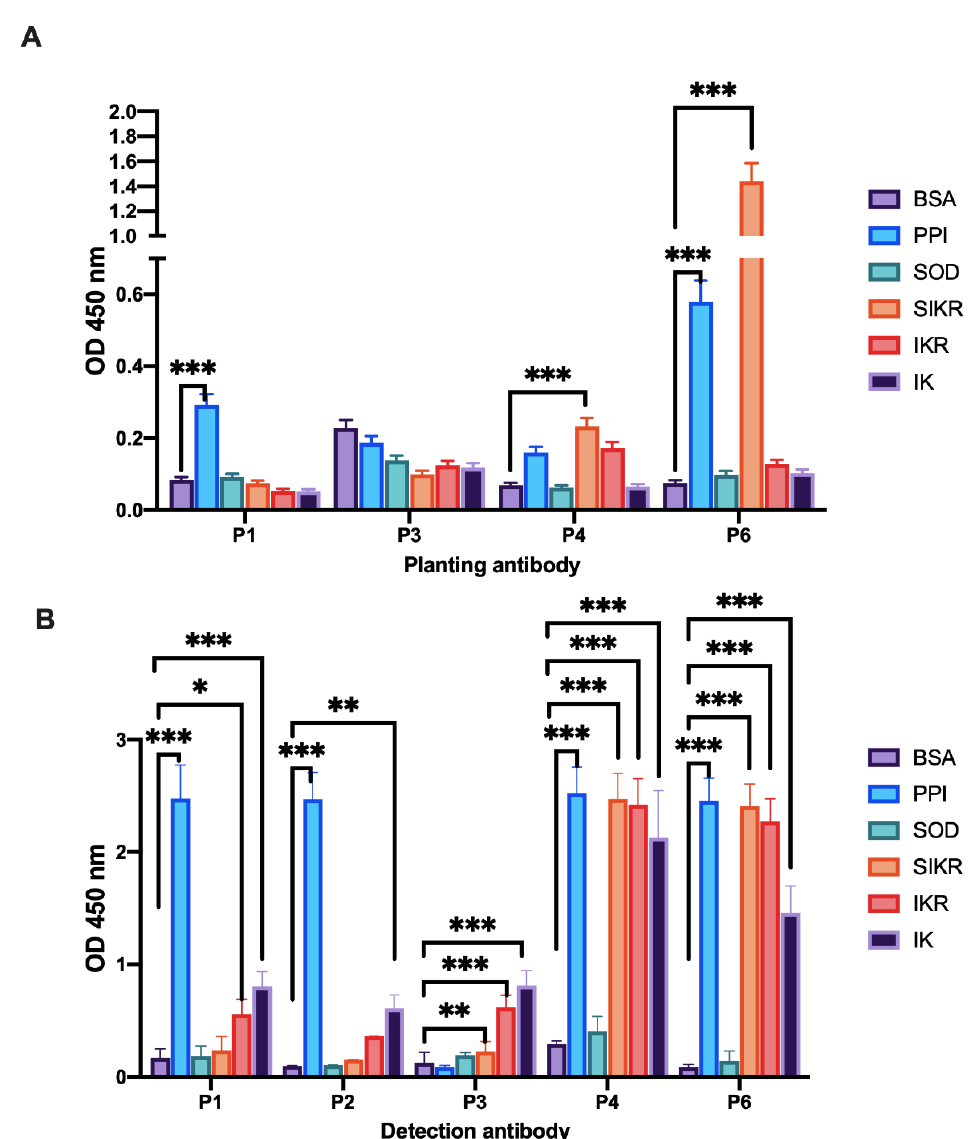
Figure 3. Specificity evaluation of paired antibody. ( A ) Plating antibodies are listed below the X - axis, detection antibodies is P5. ( B ) Plating antibodies is P5, detection antibodies are listed below the X -axis. * p < 0.05; ** p < 0.01; *** p < 0.001. X -axis. * p < 0.05; ** p < 0.01; *** p <